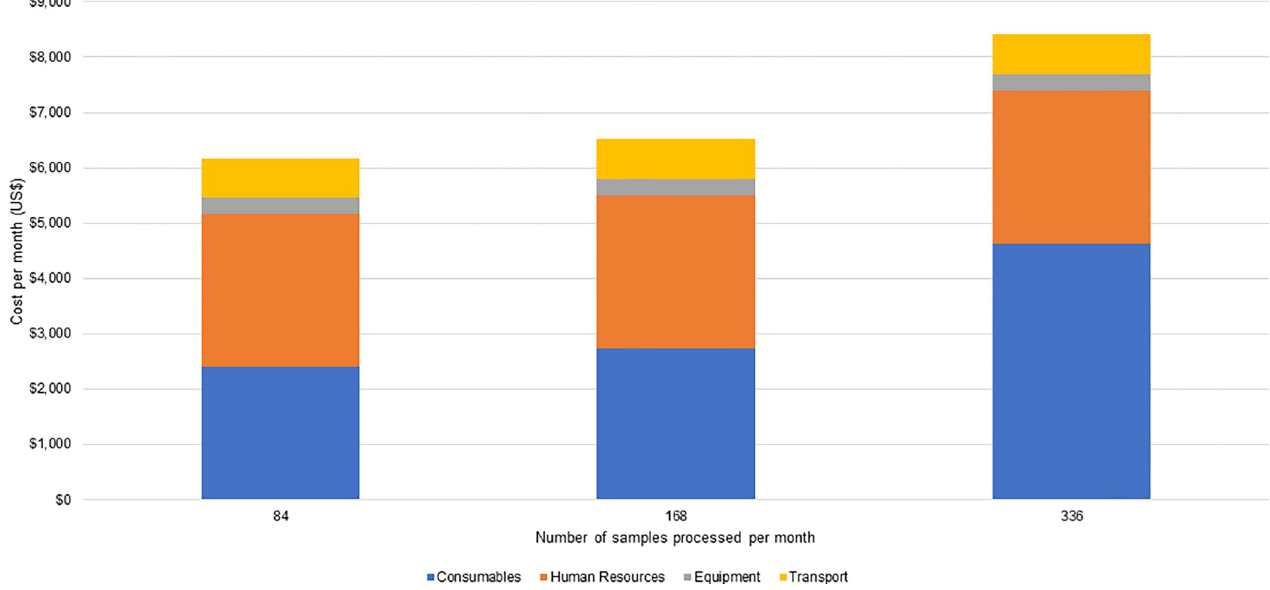
Fig 1. Monthly costs for SARS-CoV-2 ES in 2021 US$ at the Blantyre pilot site.